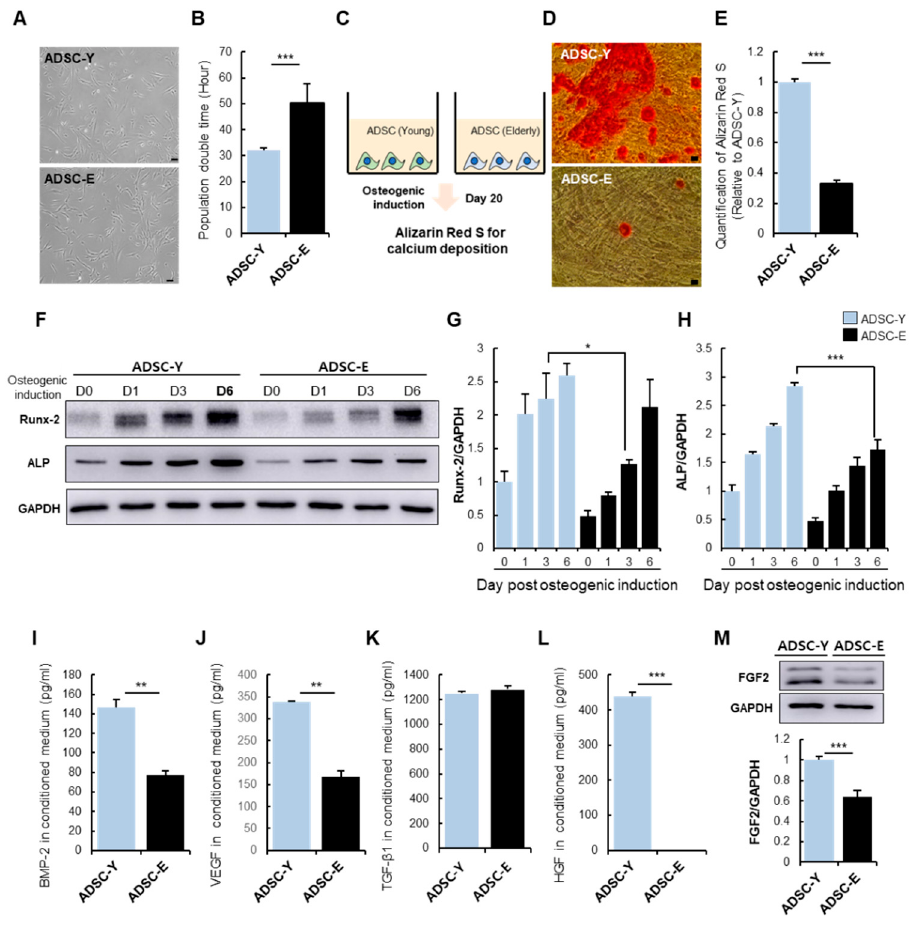
Figure 1. Effect of age on the osteogenic/paracrine potential of ADSCs.( A ) Comparison of cellular morphology of ADSC-Y and ADSC-E. Scale bar, 100 μ m. ( B ) Population doubling time was analyzed. ( C ) Experimental scheme for comparative analysis of osteogenesis in ADSC-Y and ADSC-E. ( D ) Representative images for Alizarin Red S staining of ADSC-Y and ADSC-E after osteogenic induction for 20 days. Scale bar, 100 μ m. ( E ) Alizarin Red was quantified with 10% ( w/v ) cetylpyridinium chloride. ( F ) ADSC was lysed at 0, 1, 3, and 6 days after osteogenic induction to analyze osteogenic markers. ( G , H ) Expression of Runx-2 and ALP was confirmed by western blot. ( I – L ) The level of BMP-2, VEGF, TGF- β 1, and HGF in the conditioned medium of ADSC-Y and ADSC-E was quantified by ELISA. ( M ) Protein level of FGF-2 was determined by western blot and quantified by ImageJ. Results are shown as the mean ± SD of three replicate wells for each group. * p < 0.05, ** p < 0.01, and *** p < 0.001.